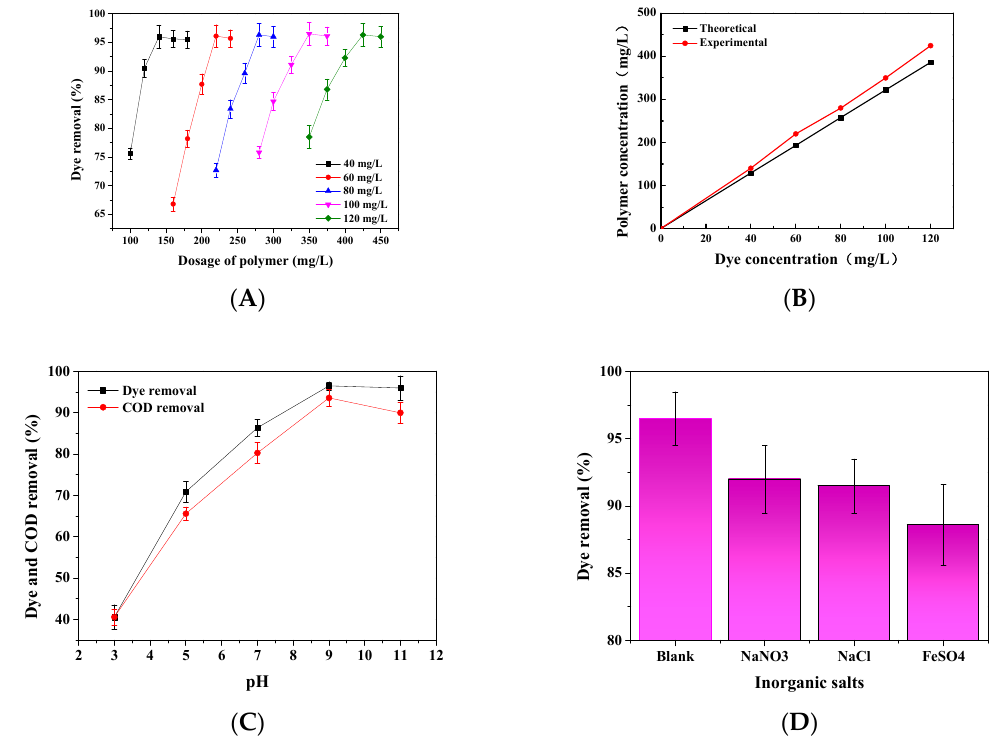
Figure 9. ( A ) The effect of initial dye and phosphorylated xylan concentrations on dye removal under conditions of 30 °C and pH 9; ( B ) the relationship between optimum and theoretical phosphorylated xylan dosage and initial concentration; ( C ) the effect of pH on dye removal under conditions of 100 mg/L dye concentration, 350 mg/L phosphorylated xylan concentration and 30 °C; and ( D ) the effect of inorganic salts on dye removal under the conditions of 100 mg/L dye concentration, 350 mg/L phosphorylated xylan concentration, pH 9, and 30 °C.